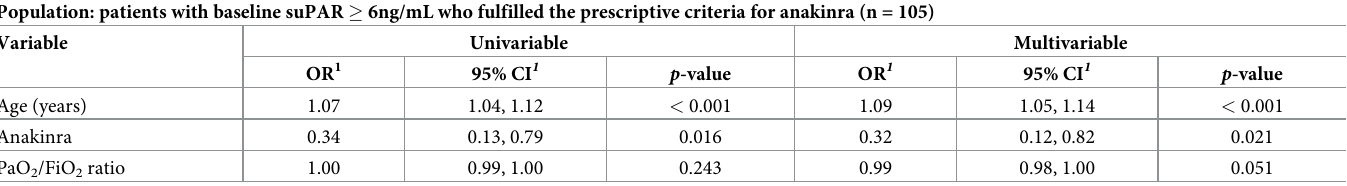
Table 4. Propensity-adjusted multiple logistic regression for risk factors associated with progression towards severe disease or death at day 14. Population: patients with baseline suPAR � 6ng/mL who fulfilled the prescriptive criteria for anakinra (n = 105)